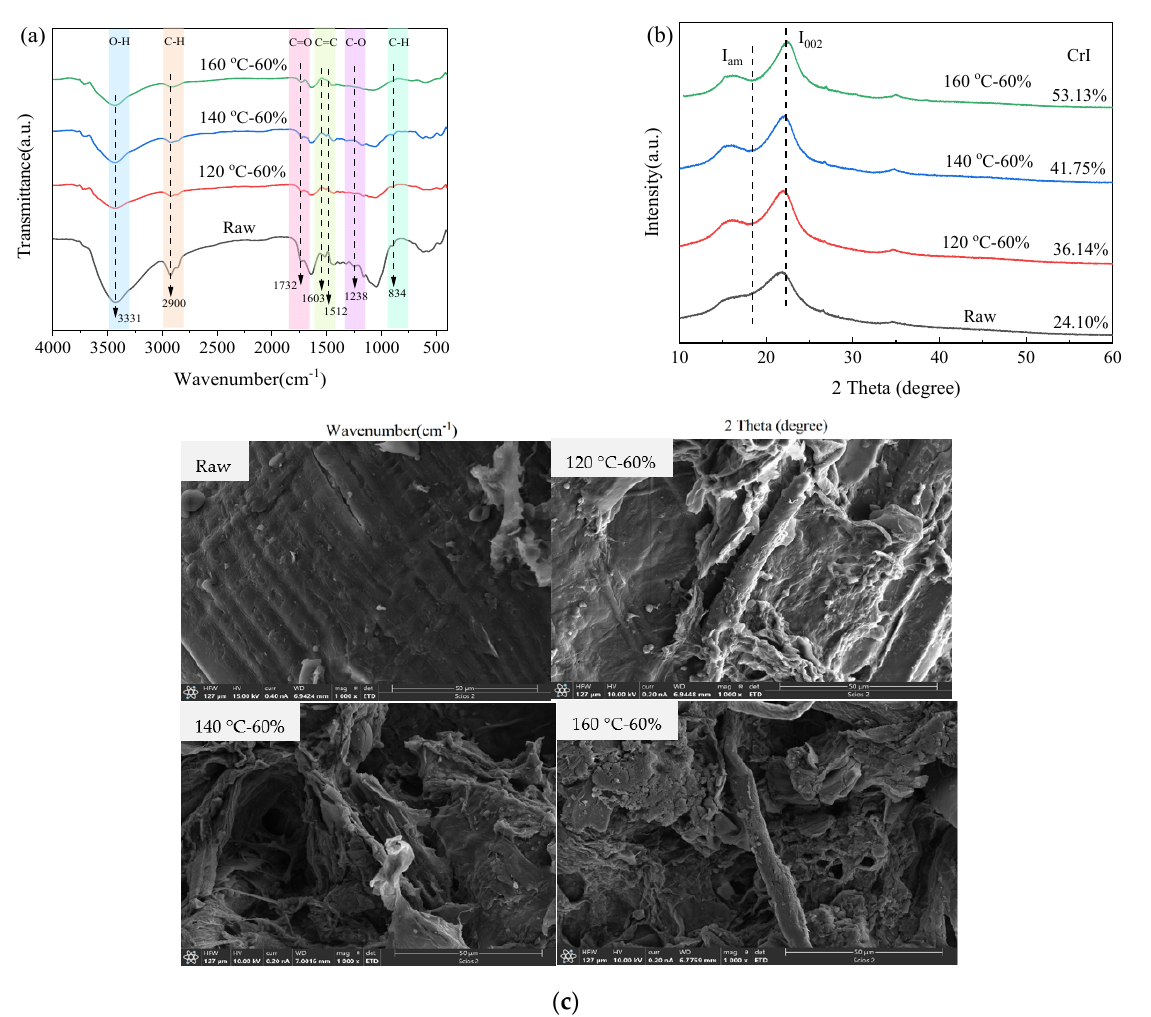
Figure 4. Characterization of different samples. ( a ) FTIR spectra of different samples. ( b ) XRD spectra and ( c ) SEM images of different samples.